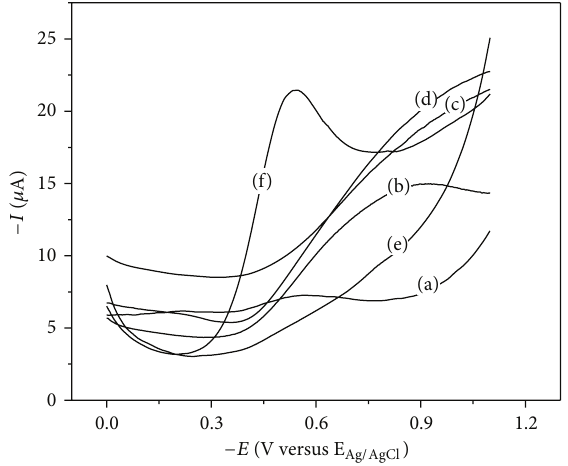
Figure 2: SWV curves for 2,4-D (10.5 mgL −1 ) in 0.1mol L −1 BR buffersolution(pH2.0)obtainedusingdifferentworkingelectrodes: (a) blank in glassy carbon, (b) 2,4-D in glassy carbon, (c) blank in carbon paste, (d) 2,4-D in carbon paste, (e) blank in GPU, and (f) 2,4-D in GPU. Parameters: 𝑓 = 50 s −1 , 𝑎 = 0.50 V, Δ𝐸 𝑖 = 0.03 V, 𝑡 = 10 s, and 𝐸 = 0.0 acc